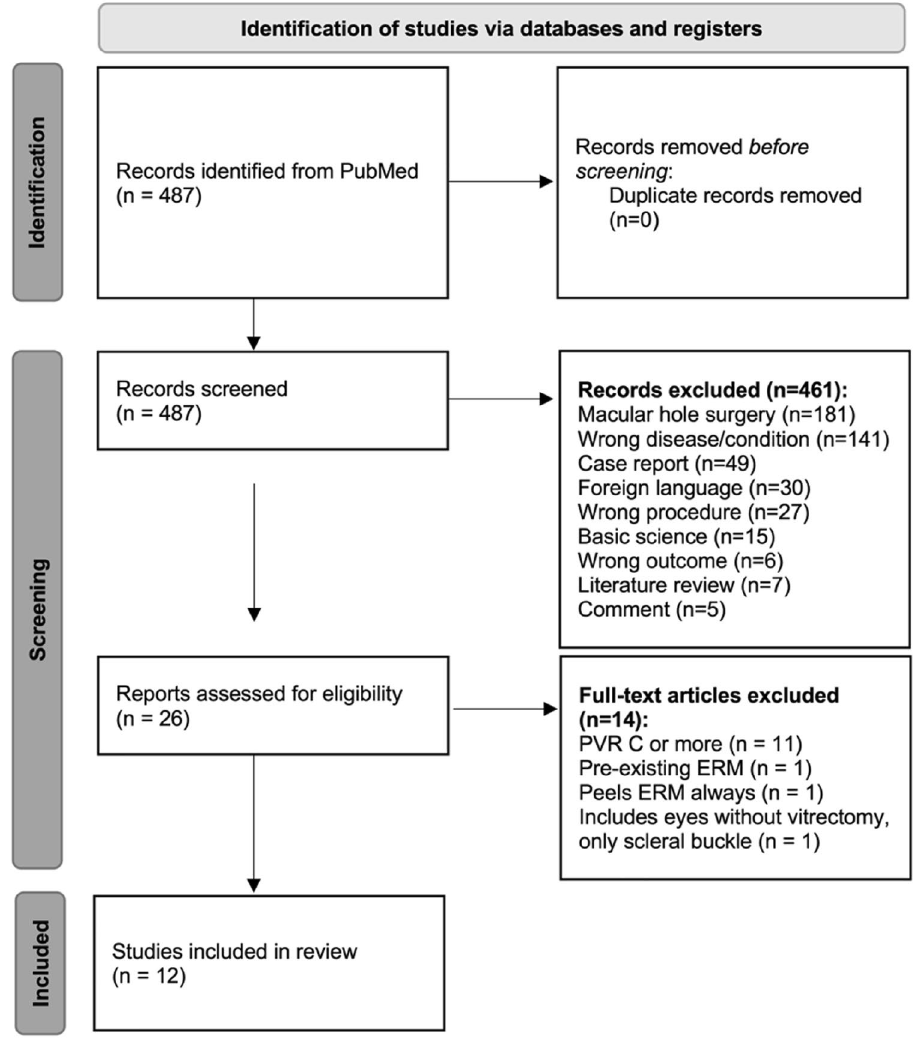
Figure 1. PRISMA flow diagram for study